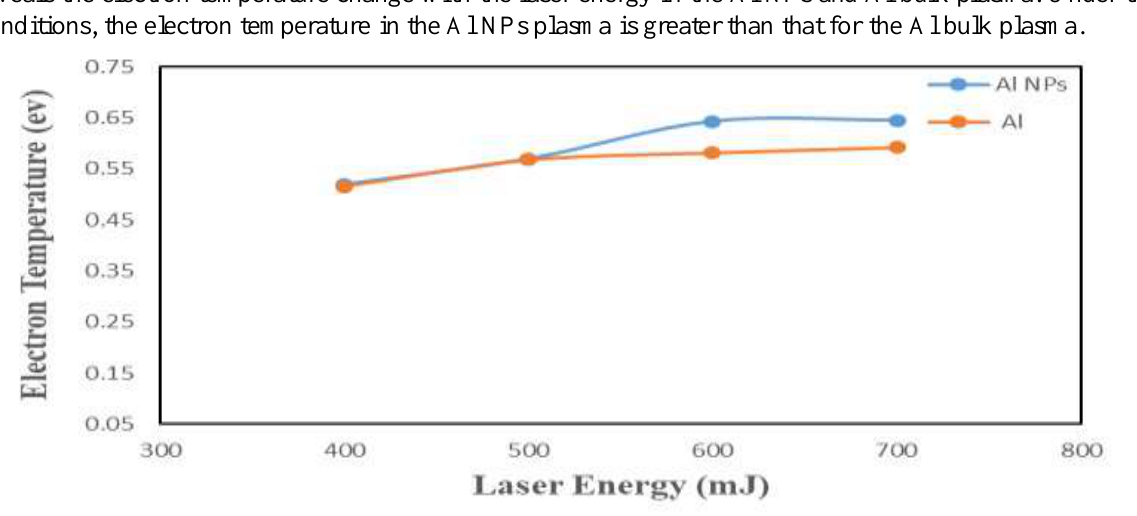
Figure 7: The variation of electron temperature with laser energy in Al bulk and Al NPs plasma at atmospheric pressure.